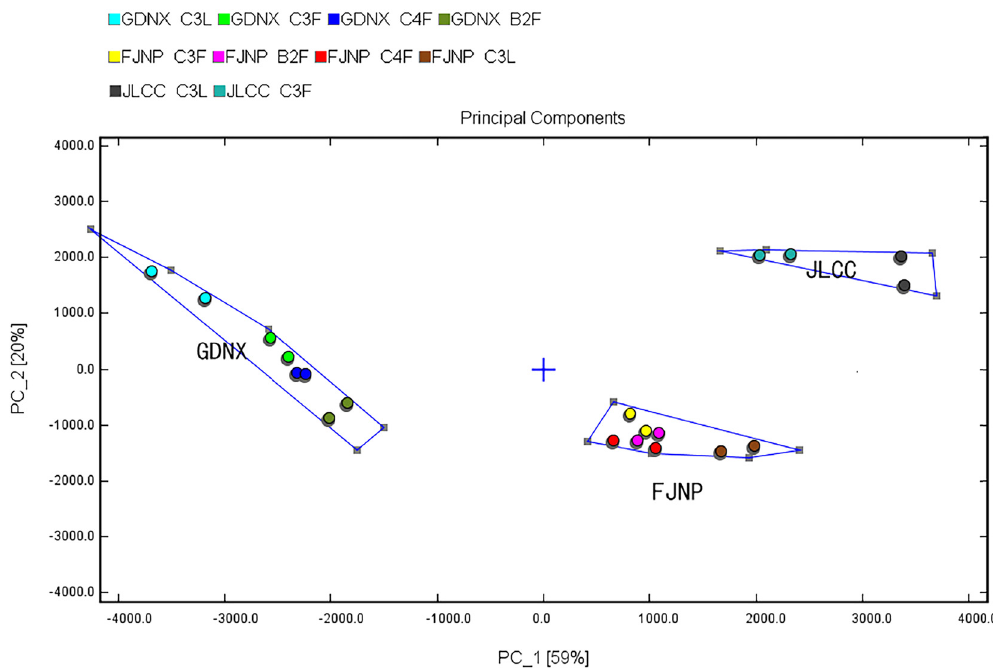
Figure 4: PCA plots of all tobacco